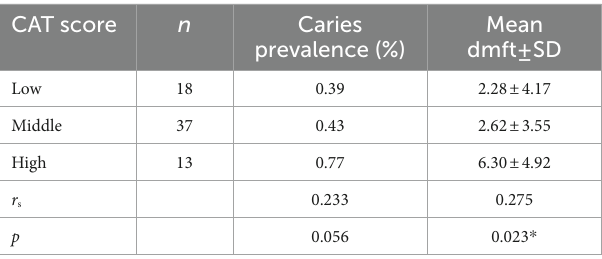
TABLE 6 Relationship between the caries activity test (CAT) score, caries prevalence, and mean dmft value.